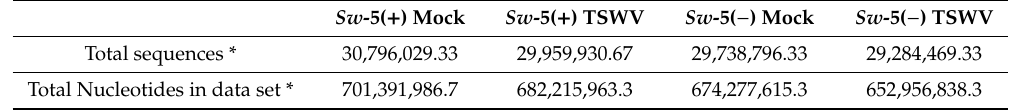
Table 1. Number of reads predicted from tomato varieties with or without Sw -5 following inoculation by TSWV or buffer (mock). Each value is the average of three replicates, after clean reads from 18 to 34 nucleotides.